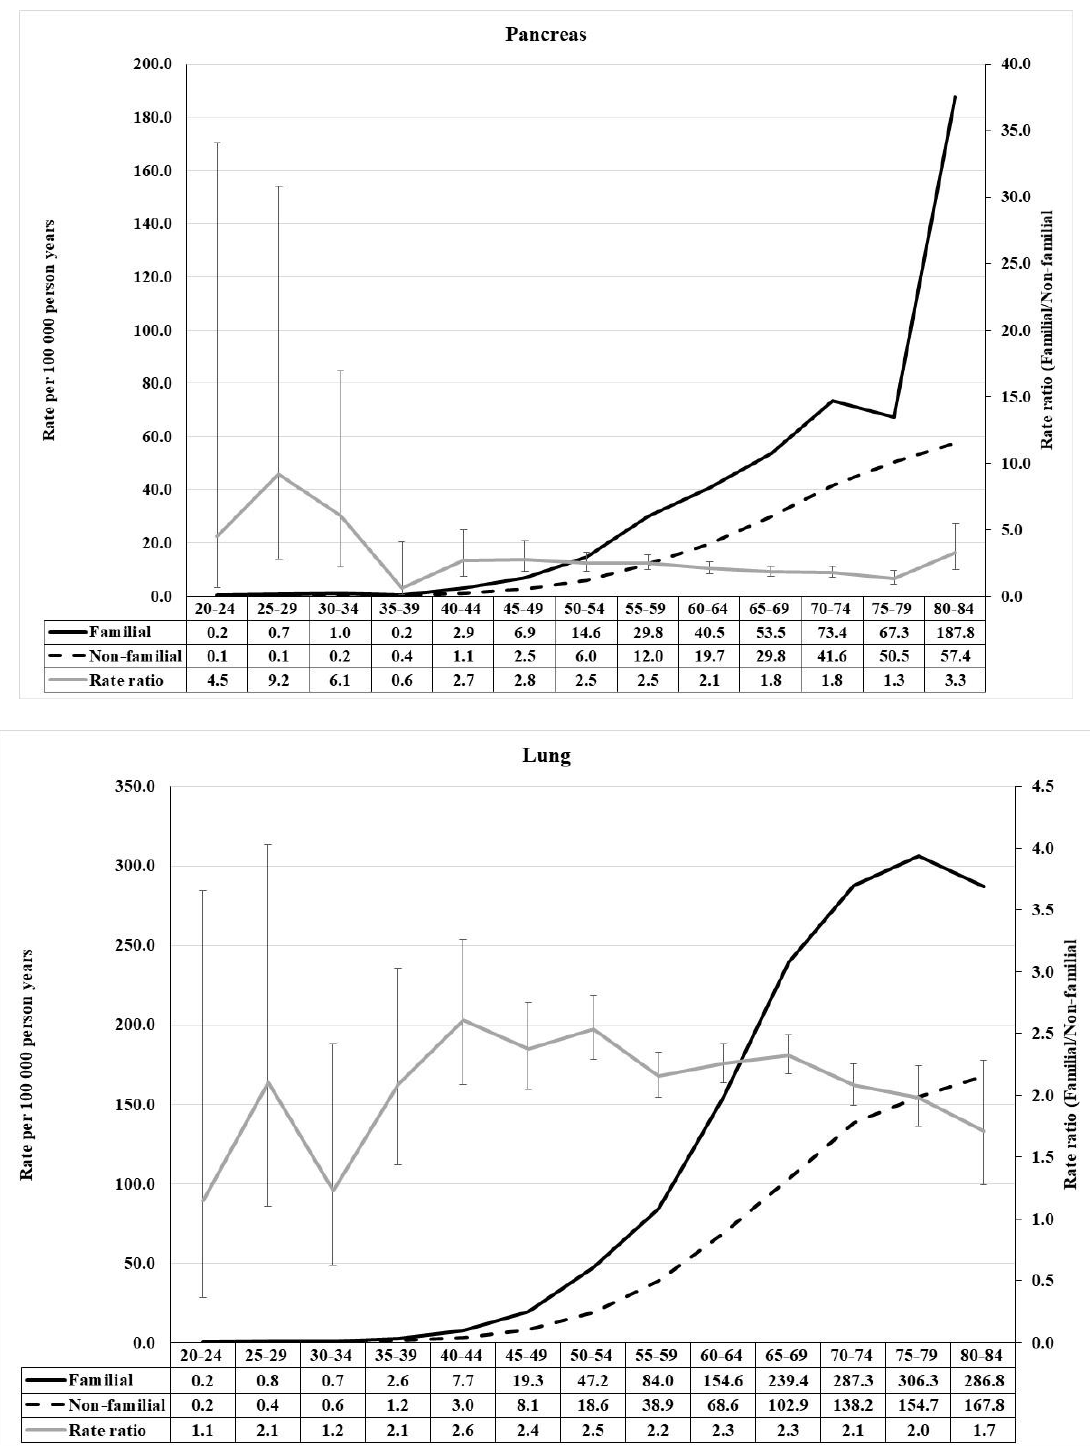
Figure 2. Age-specific incidence rate and rate ratio of pancreas ( upper ) and lung ( lower ) cancer in population with and without family history of concordant cancer.